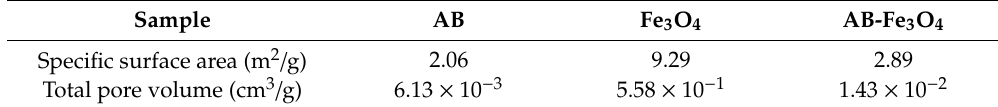
Table 2. Textural characteristics of AB, Fe 3 O 4 , and AB-Fe 3 O 4 .